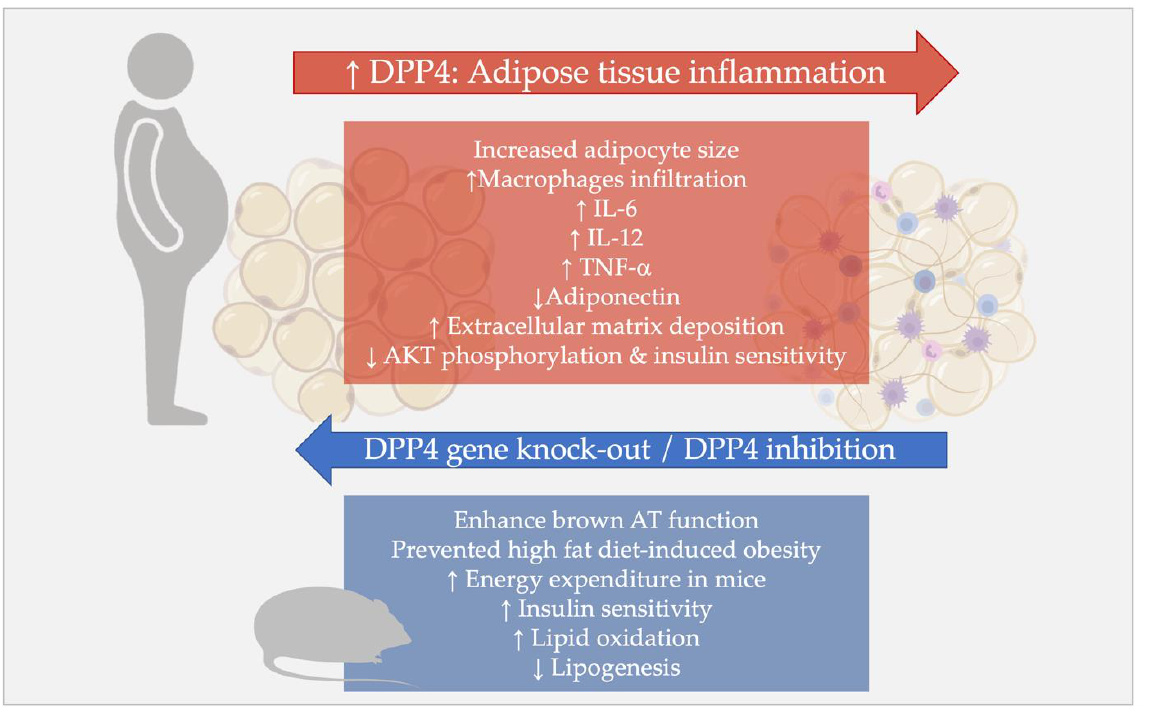
Figure 1. DPP4 in the adipose tissue. The red box shows the relationship between DPP4 and visceral adipose tissue inflammation, tissue remodeling, and dysfunction in humans. The blue box shows experimental data resulting from DPP4 ablation and pharmacological inhibition in rodents. Up arrows indicate an increase, down arrows a decrease. Abbreviations: DPP4: dipeptidyl peptidase 4, IL-6: interleukin 6, IL-12: interleukin 12, TNF- α : tumor necrosis factor α , AKT: protein kinase B; AT: adipose tissue. See Sections 4.1 and 4.2 for detailed description and